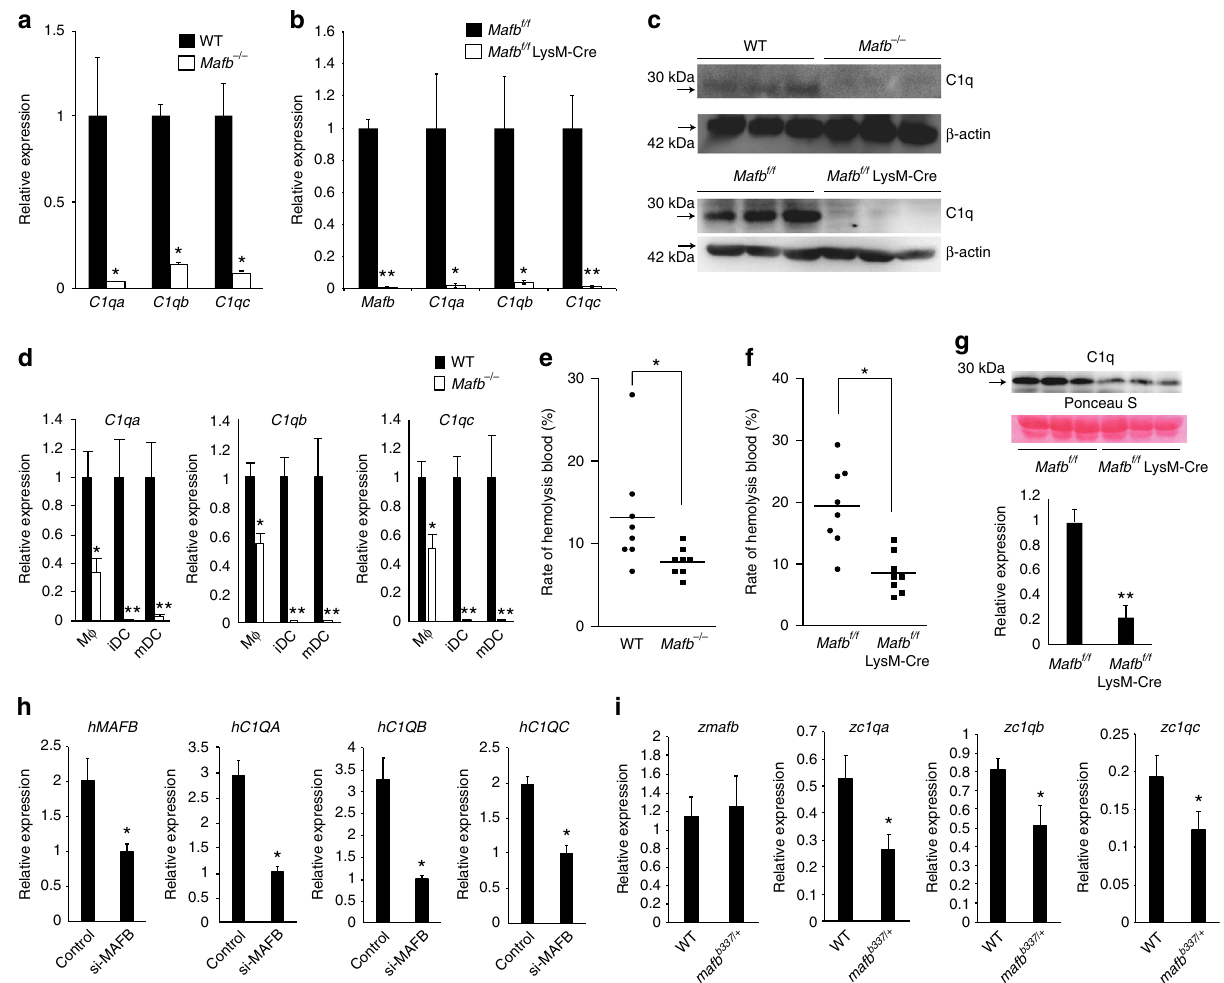
Fig. 2 C1q gene expression is decreased in Mafb − / − macrophages. a Messenger RNAs of C1q genes in PMs were examined by qRT-PCR ( n = 3 for each group). b PMs of Mafb f/f ::LysM-Cre and Mafb f/f were analyzed for the expression of the Mafb and C1q genes ( n = 4 for each group). c A western blot analysis was performed to measure C1q protein levels in the PMs of WT and Mafb − / − . The protein extracts were normalized to β -actin expression. The data are from one experiment that was representative of at least two independent experiments. d The C1q genes were analyzed by qRT-PCR of macrophages and immature DCs from WT or Mafb − / − ( n = 4 for each group). The data are from one experiment that was representative of at least two independent experiments. a , b , d The data were normalized to Hprt mRNA and are presented as the mean ± s.e.m. * p < 0.05 compared with WT, ** p < 0.01 (Student ’ s t -test). e , f The hemolysis rates were analyzed using serum from fetal liver cell-transplanted mice 3 months after transplantation ( e ) or Mafb f/f ::LysM-Cre and control mice (8 – 10 weeks old) ( f ). The data were analyzed with the Mann – Whitney U-test, and the results from two independent experiments were pooled. g A western blot analysis was performed to measure the C1q protein levels in the serum of 8-week-old WT and Mafb − / − mice. Lower panel, the data were normalized to the protein band of Ponceau S and are presented as the mean ± s.e.m. ** p < 0.01 compared with Mafb f/f (Student ’ s t -test). The data are from one experiment that was representative of at least two independent experiments. h THP-1 cells were transfected with either control siRNA (si-control) or MAFB siRNA (si-MAFB). The cells were stimulated with dexamethasone and IFN γ for 24h after PMA stimulation. The data were normalized to HPRT mRNA and are presented as the mean ± s.e.m. n = 4 for each group. * p < 0.05 compared with si-control ( Mafb, C1qa, C1qc , Student ’ s t -test; C1qb , Welch ’ s t -test). The data are from one experiment that was representative of two independent experiments. i qRT-PCR was conducted using heterozygous mafb b337/ + mutant zebra fi sh. The data were normalized to csf1r mRNA and are presented as the mean ± s.e.m. WT; n = 7, mafb b337 /+ ; n = 6 for each group. * p < 0.05 compared with WT (Student ’ s t -test). The data are from one experiment that was representative of two independent